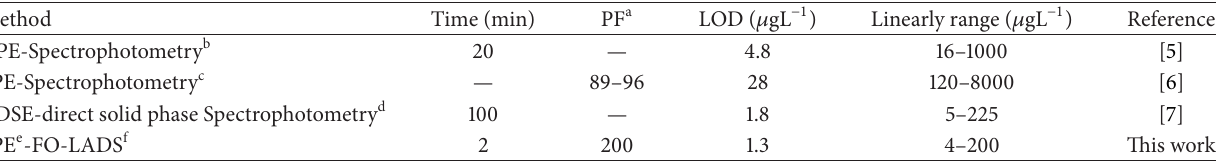
Table 3: A comparison of the represented SPE method with other reported preconcentration methods.